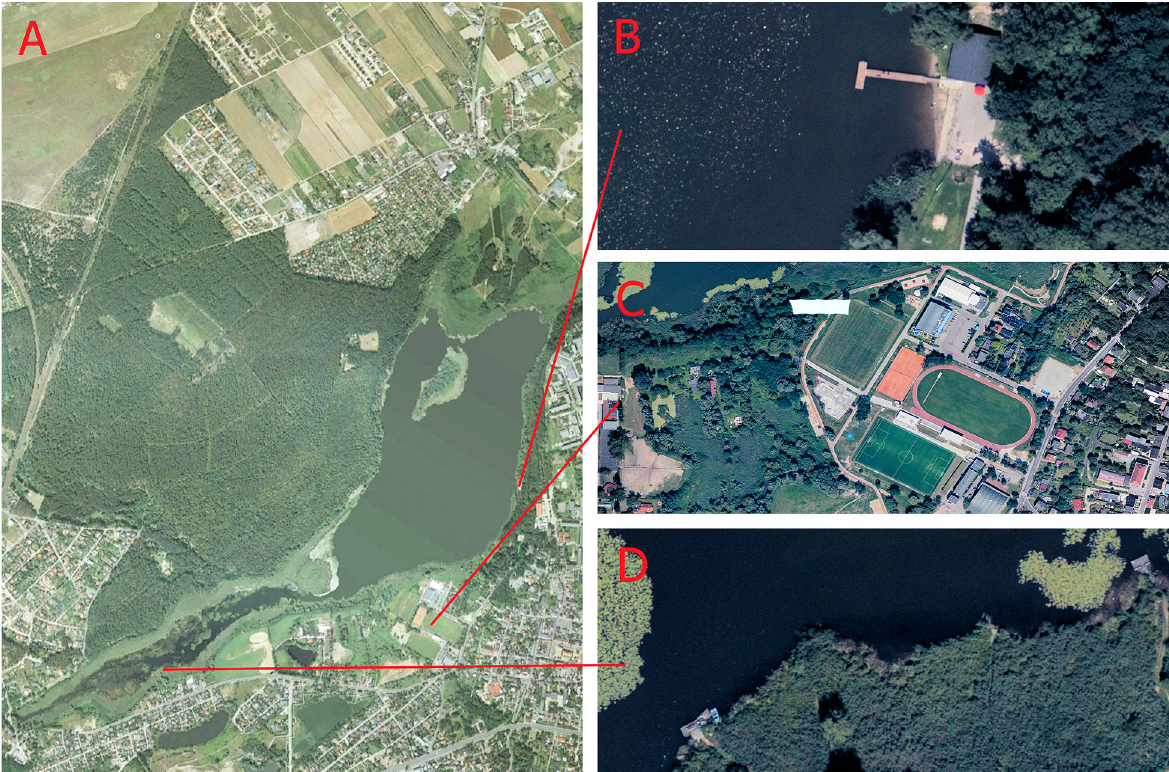
Fig. 4. Tourist and recreational infrastructure of the Lake Swarzędzkie.